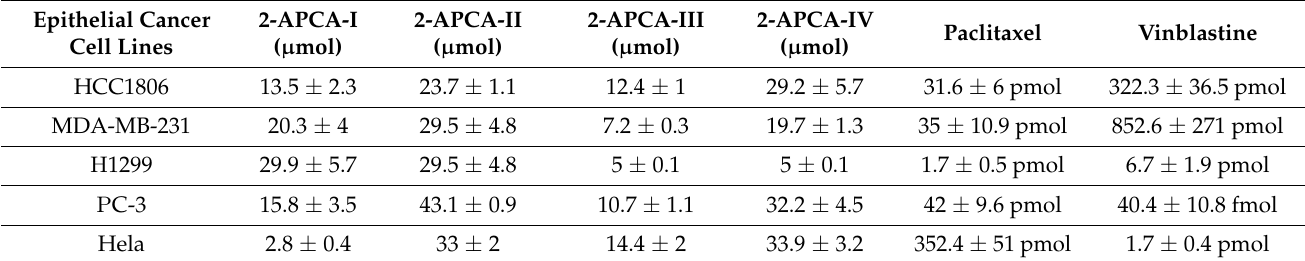
Table 2. IC50 values for 2-APCAs (I-IV), paclitaxel, and vinblastine for epithelial cancer cell lines. Epithelial Cancer